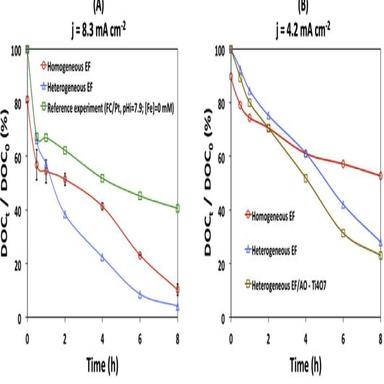
DOC removal efficiency vs time during the mineralization of NF concentrate. Comparison of different configurations and operating conditions. (A) J ¼ 8.3 mA cm¡2 : ( ) Homogeneous EF with CF cathode, Pt anode, ¼ 0.2 mmol L-1 , pH0 ¼ 3; ( ) Heterogeneous EF with FeIIFeIII-LDH modified CF cathode, Pt anode, ¼ 0 mmol L-1 , pH0 ¼ 7.9; ( ) Reference experiment with CF cathode, Pt anode, ¼ 0 mmol L-1 , pH0 ¼ 7.9. Three homogeneous EF experiments were performed in order to assess the reproducibility of the exper